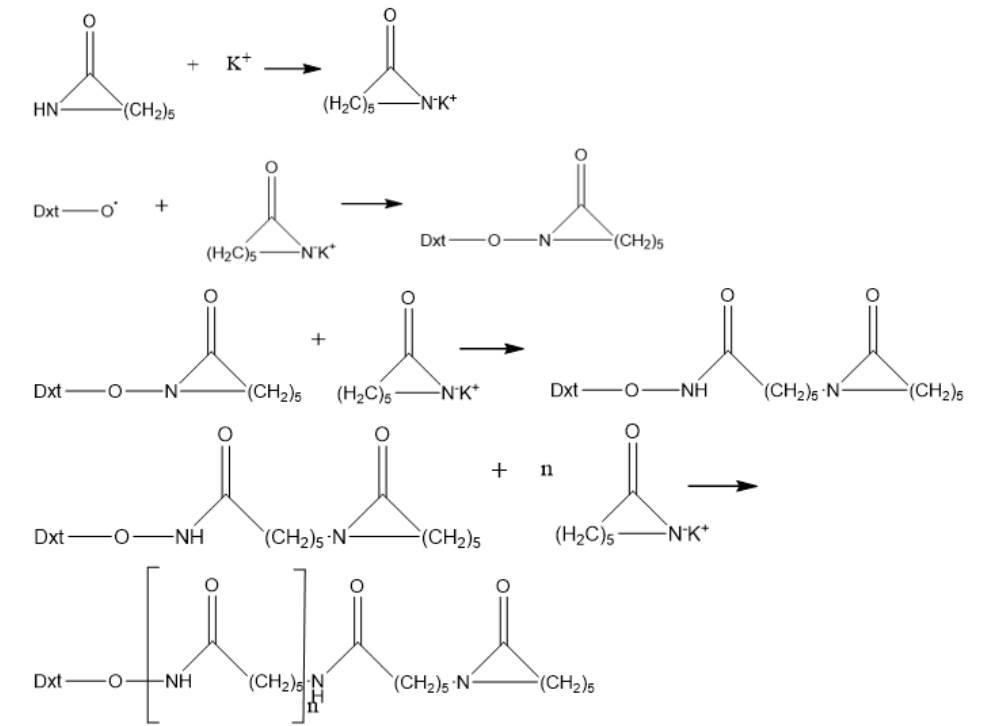
Figure 2. Chain growth reaction mechanism.